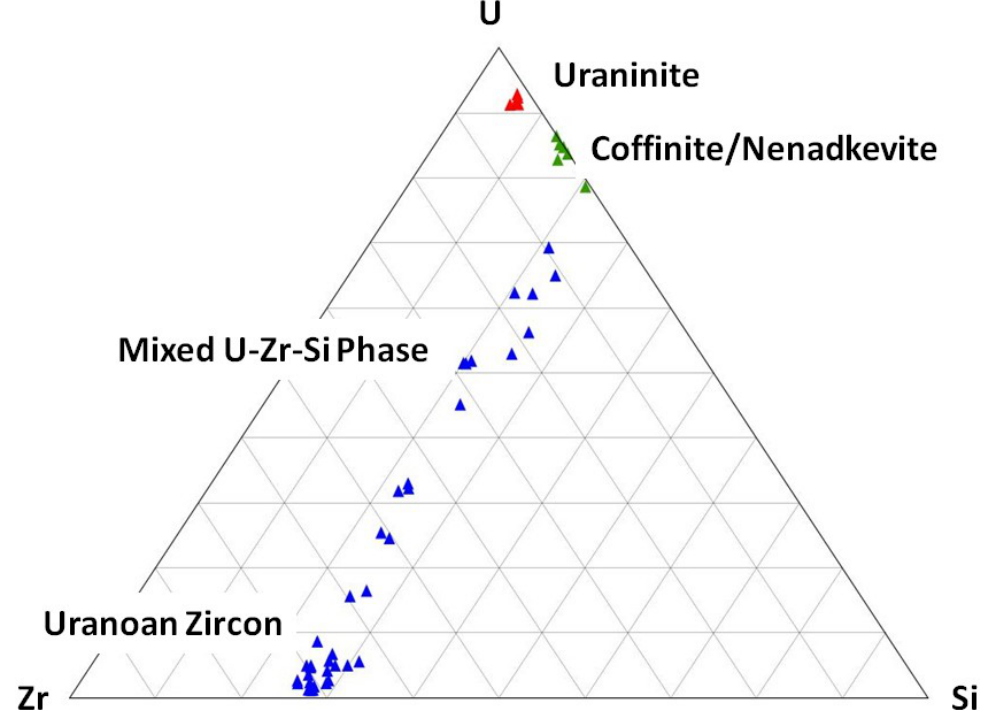
Figure 10. Ternary diagram illustrating range in composition of uranium minerals from Valhalla, Skal and Bikini. “Uranoan zircon” refers to early subhedral inclusions in albite rather than later microveinlets along grain